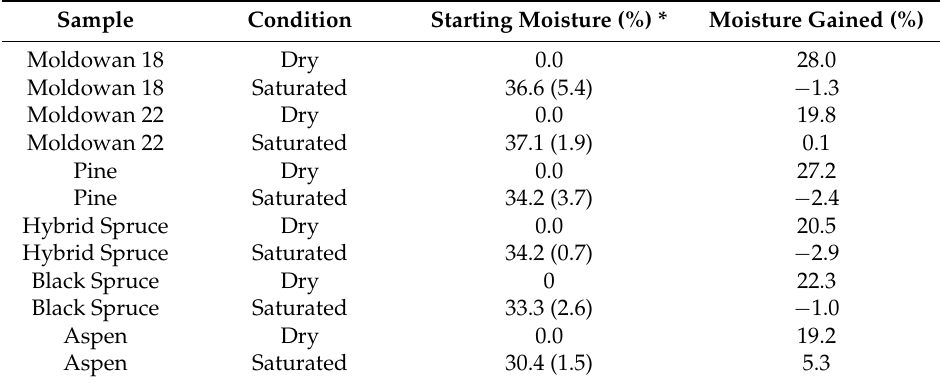
Table 3. Wood chip moisture mean levels for dry and saturated runs as well as moisture gained ( n = 10) in the rainfall simulation experiment. Value provided in parentheses is the standard error.